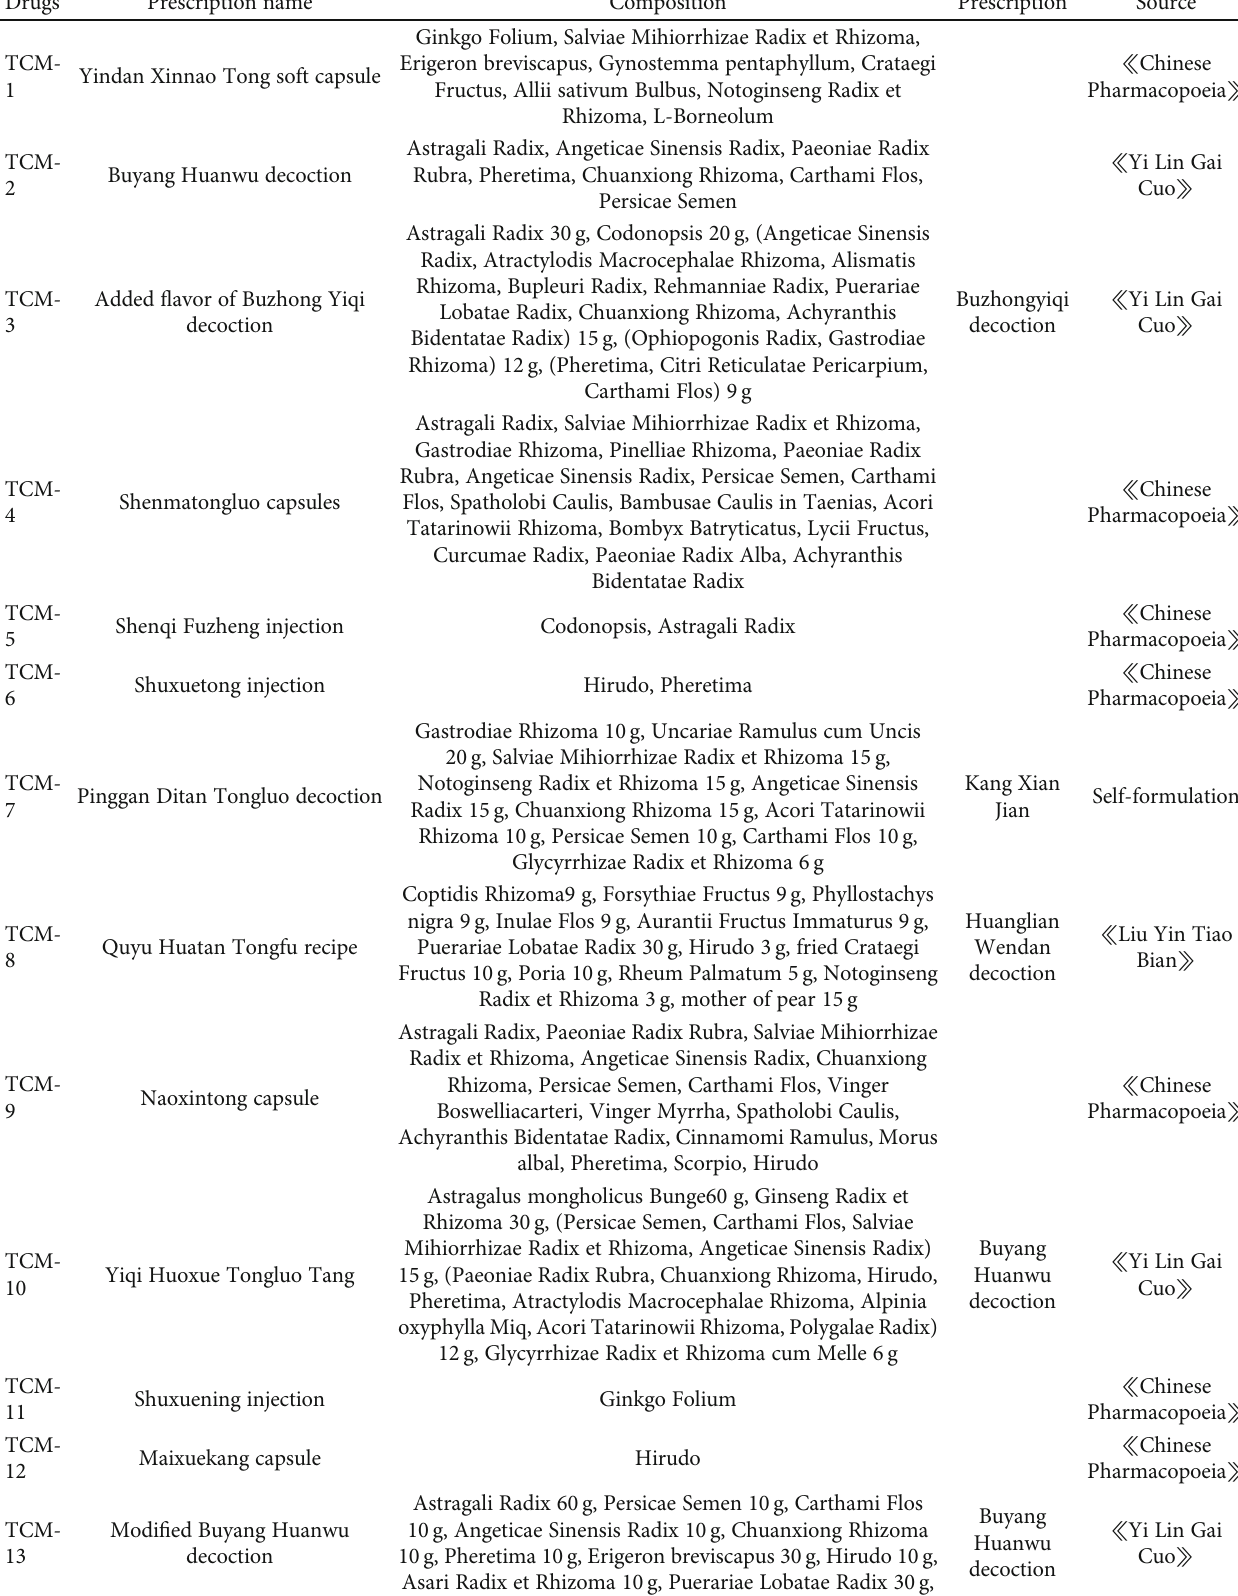
Table 3: Prescription of TCM and its